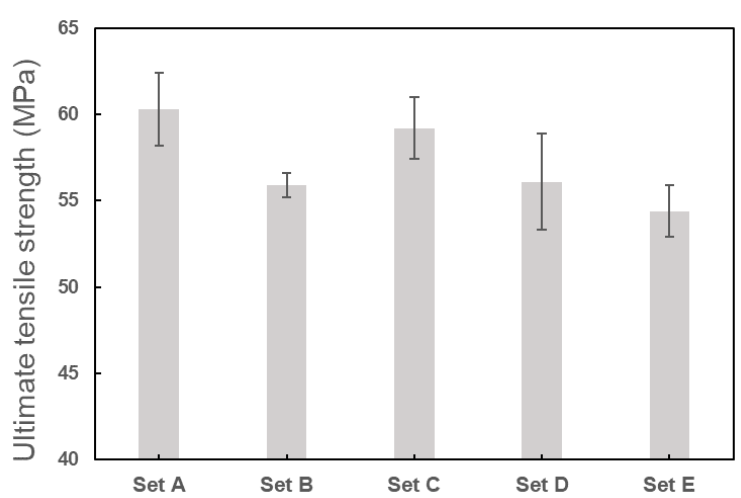
Figure 10. Experimental data of ultimate tensile strength for each set of specimens.